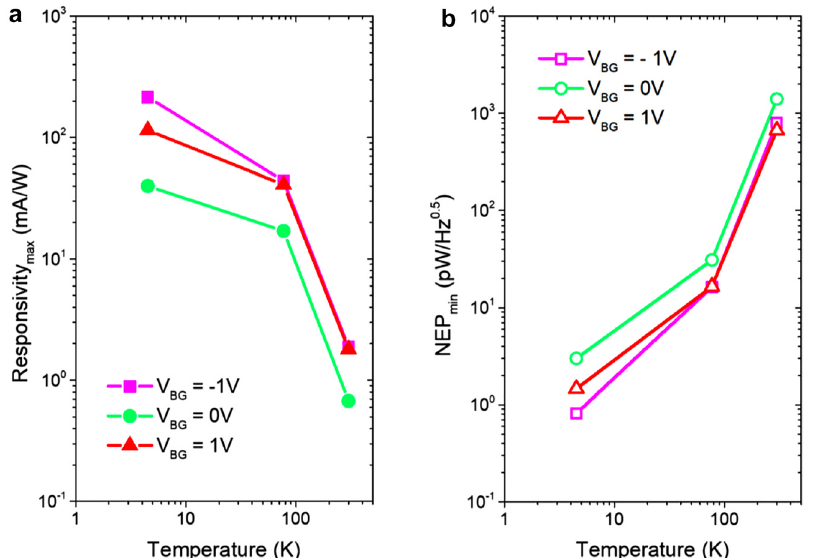
Figure5: Performance ofthe ADGG-GTeraFET